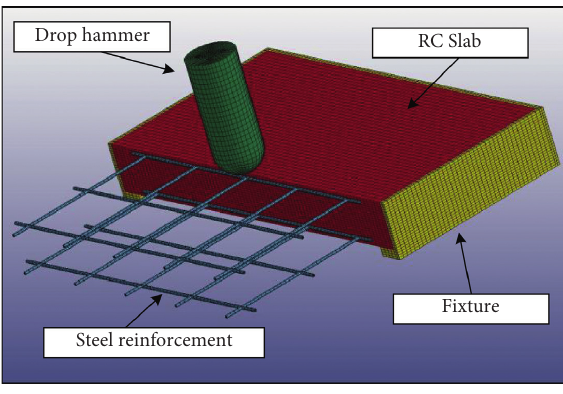
Figure 4: FEM model of drop hammer